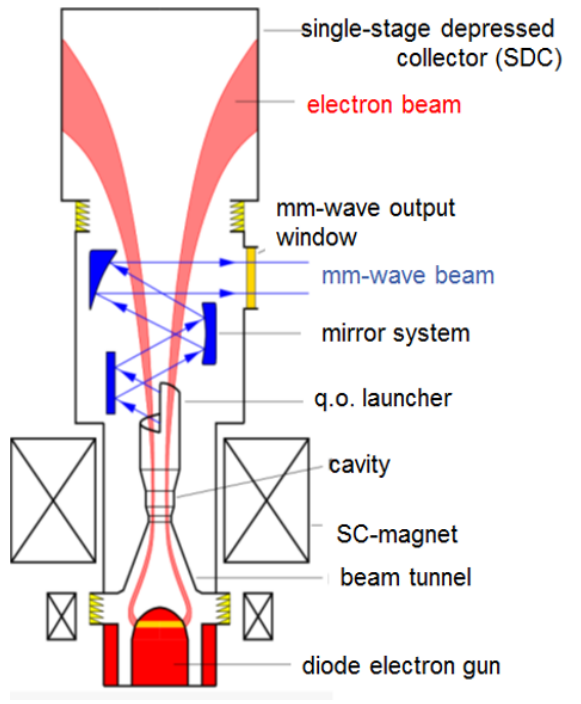
Fig. 3. Gyrotron schematics with electron beam correctly centred with respect to the superconducting (SC) magnet